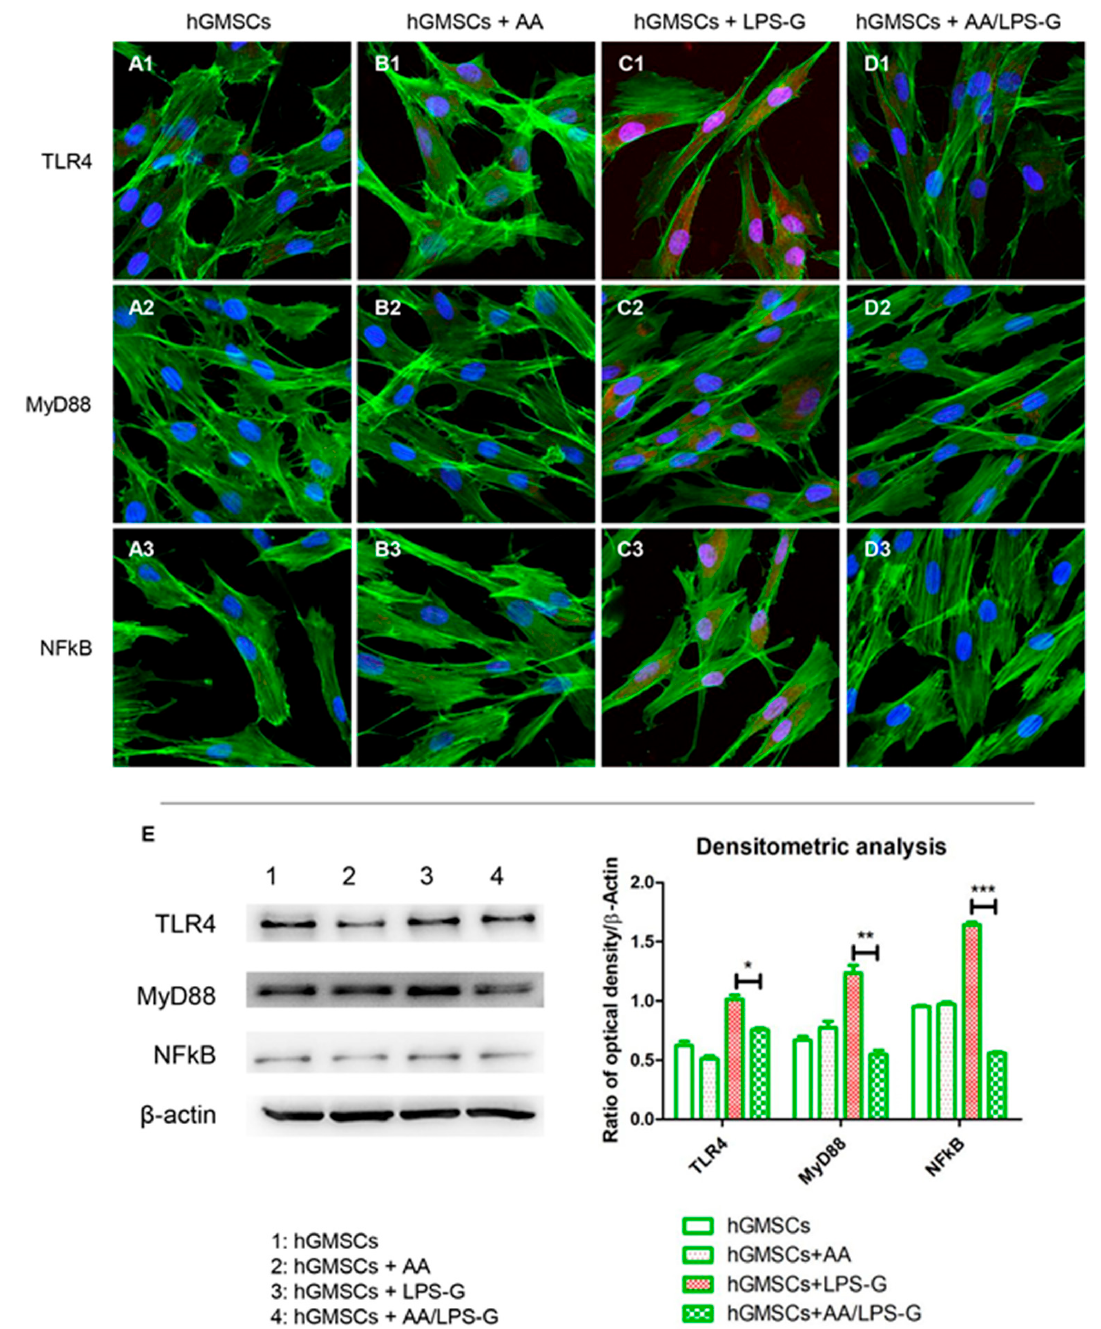
Figure 4. TLR4/MyD88/NF κ B signaling pathway and differences in protein levels in hGMSCs. Expression of TLR4, MYD88 and NF κ B, examined by confocal microscopy and Western blot experiments. ( A1 – D1 ) TLR4 expression in hGMSCs (CTRL), hGMSCs + AA, hGMSCs + LPS-G, hGMSCs + AA/LPS-G. ( A2 – D2 ) MyD88 expression in hGMSCs (CTRL), hGMSCs + AA, hGMSCs + LPS-G, hGMSCs + AA/LPS-G. ( A3 – D3 ) NF κ B expression in hGMSCs (CTRL), hGMSCs + AA, hGMSCs + LPS-G, hGMSCs + AA/LPS-G. ( E ) TLR4, MyD88 and NF κ B protein levels. β -actin was used as a loading control. Green fluorescence: cytoskeleton actin. Red fluorescence: TLR4, MYD88, NF κ B. Blue fluorescence: cell nuclei. Scale bar: 20 µ m. * p < 0.05; ** p < 0.01; *** p <